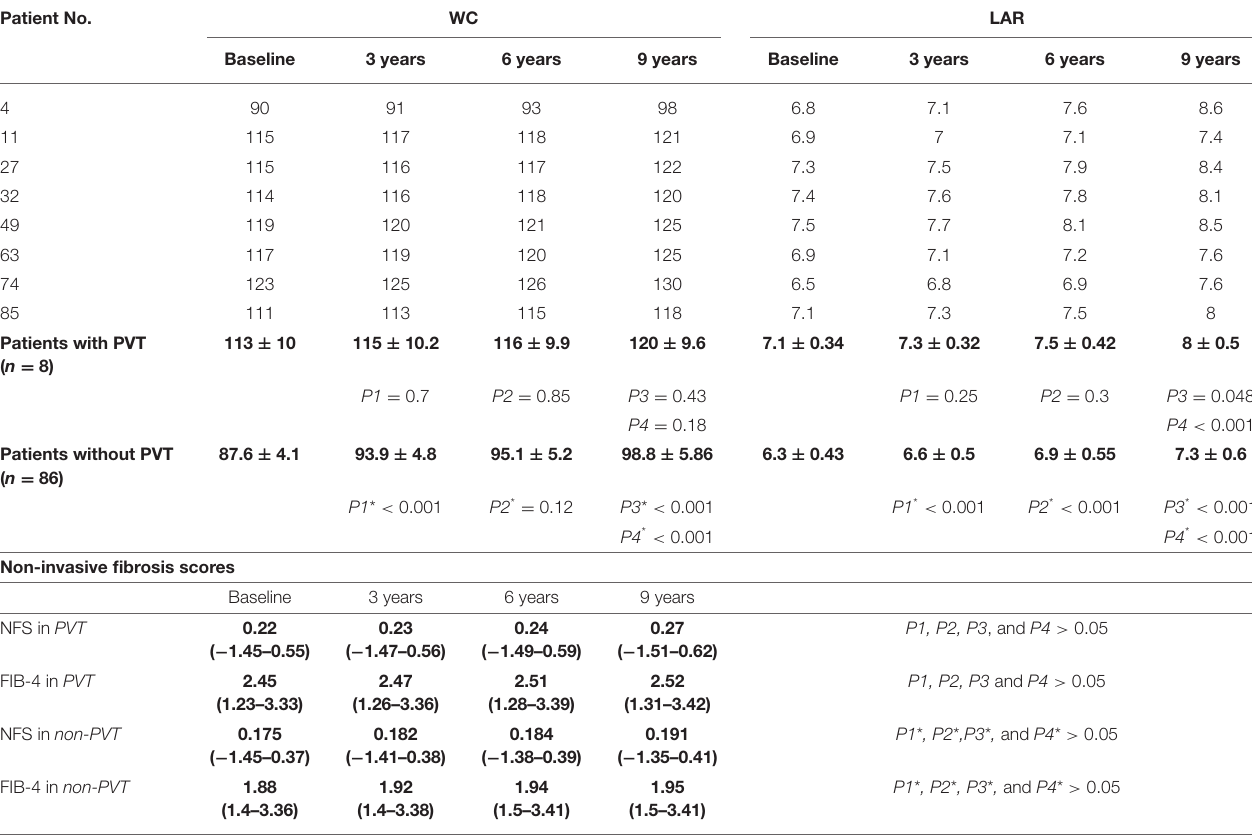
TABLE 3 | WC, LAR, and fibrosis scores in patients who developed PVT within 9 years of observation. Patient